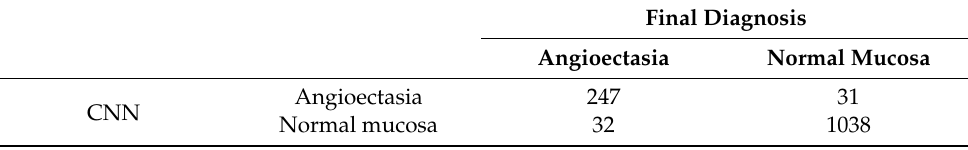
Table 1. Distribution of results.